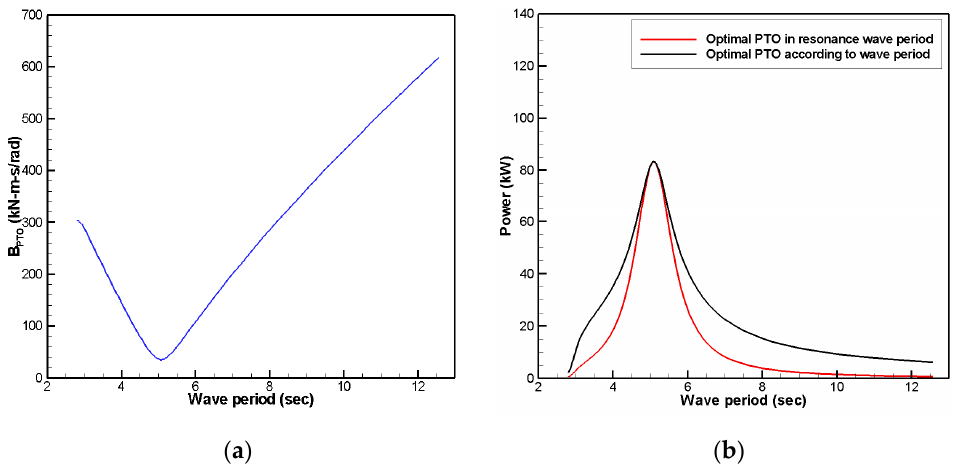
Figure 7. ( a ) Optimal PTO damping coefficient for each period. ( b ) Output power generation performance according to the optimal PTO damping coefficient for each period and resonance period PTO damping coefficient.